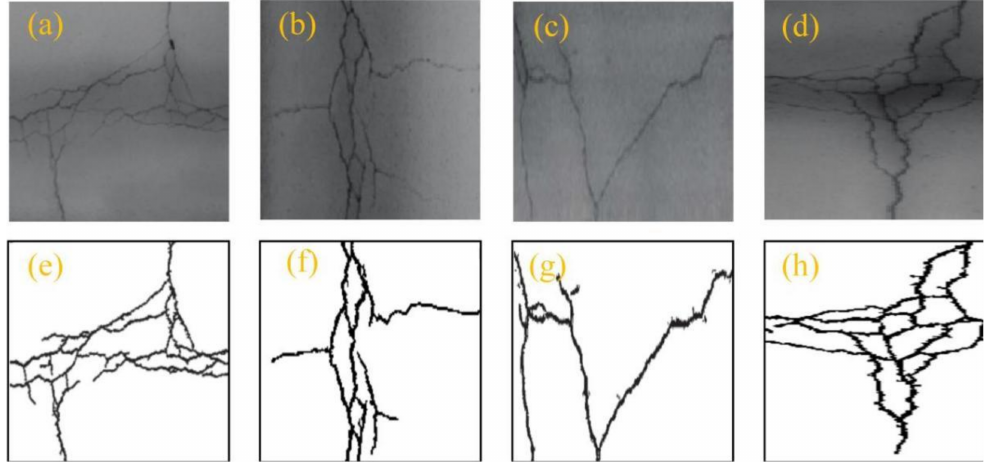
Figure 14. Segmentation results of complex concrete mesh cracks. ( a – d ) are the original images, ( e – h ) are the segmentation results of